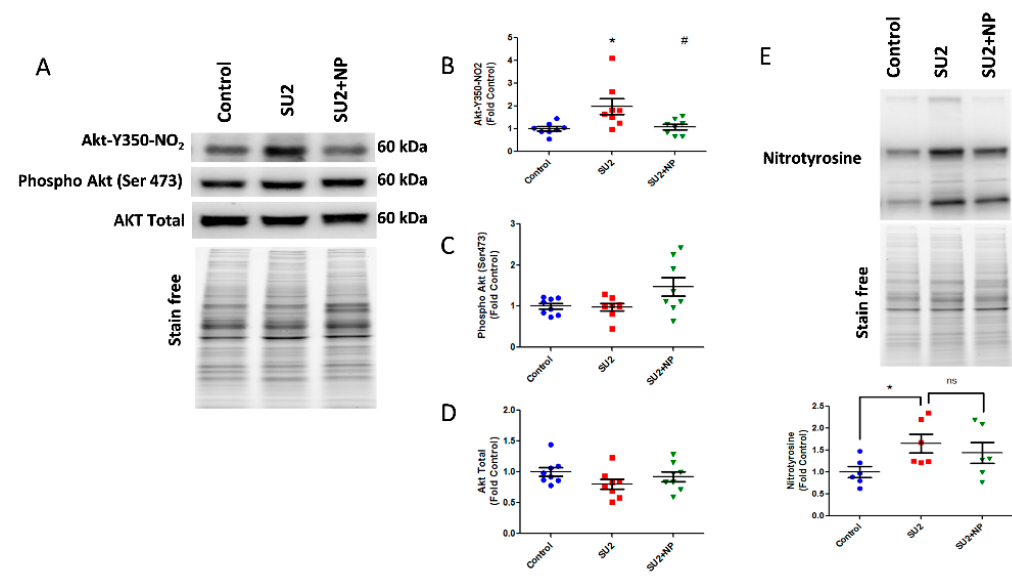
Figure 3. NP treatment attenuated Akt nitration in early PAH. ( A ) Western blot of nitro Akt, phospho Akt, and total Akt expression in the lung lysate of sugen two weeks and sugen two weeks plus NP treatment groups. ( B ) NP treatment significantly reduced nitro Akt modification. Phosphorylation of Akt at Ser-473 ( C ) and total Akt expressions ( D ) were not altered in the two-week sugen / hypoxia model and NP treatment. ( E ) Total nitration in lungs was increased in the SU2 group, and NP treatment did not attenuate the total nitration in the lung significantly; thus, this shows NP selectivity toward Akt nitration. Data expressed as mean ± SE normalized on total proteins, N = 6–8, * p < 0.05 versus control, # p < 0.05 versus SU2 by ANOVA.